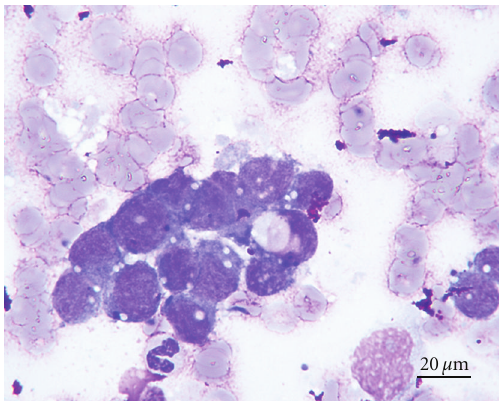
Figure 2: Histological section of a poorly di ff erentiated sarcoma. Neoplastic cells are round to fusiform and display moderate pleomorphism. Hematoxylin and eosin stain, 40x objective, bar = 100 µ m.